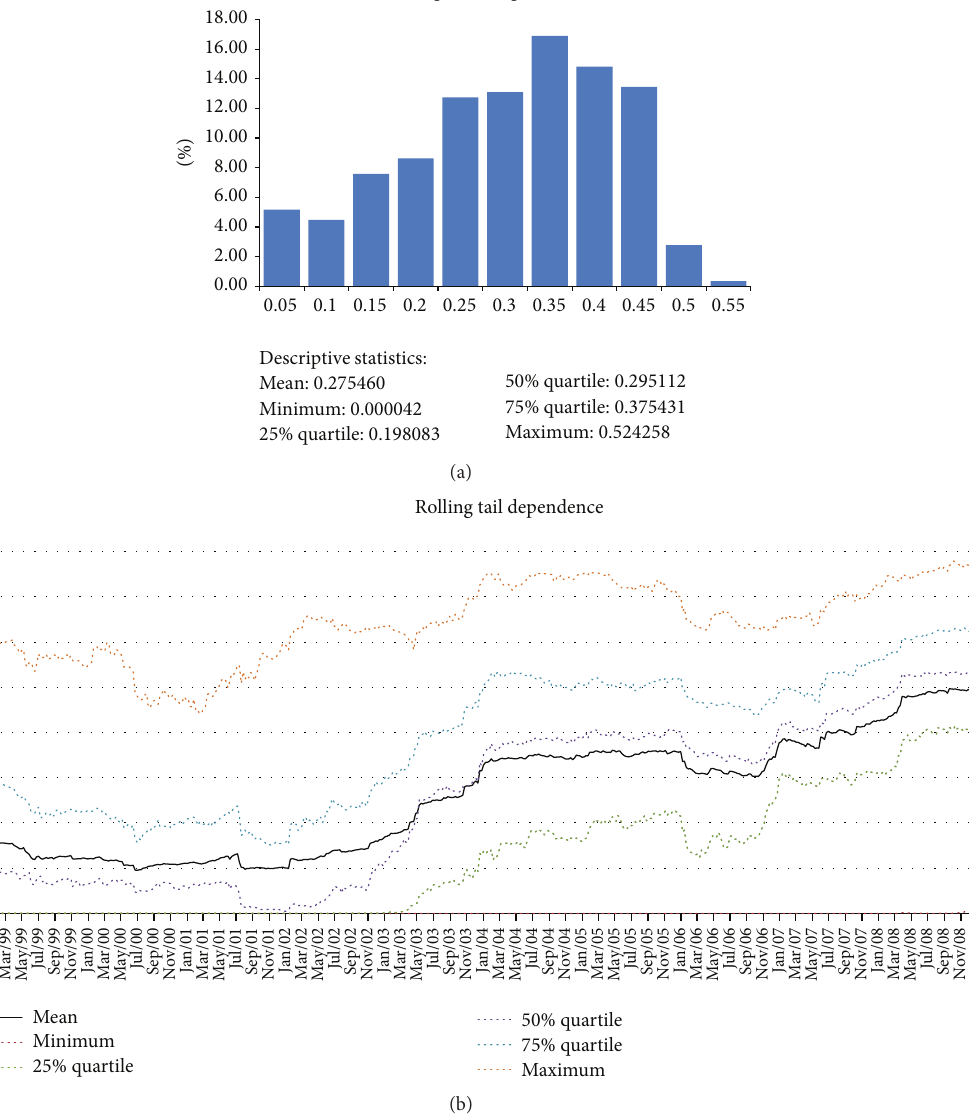
dependence and average stock returns. Nevertheless,